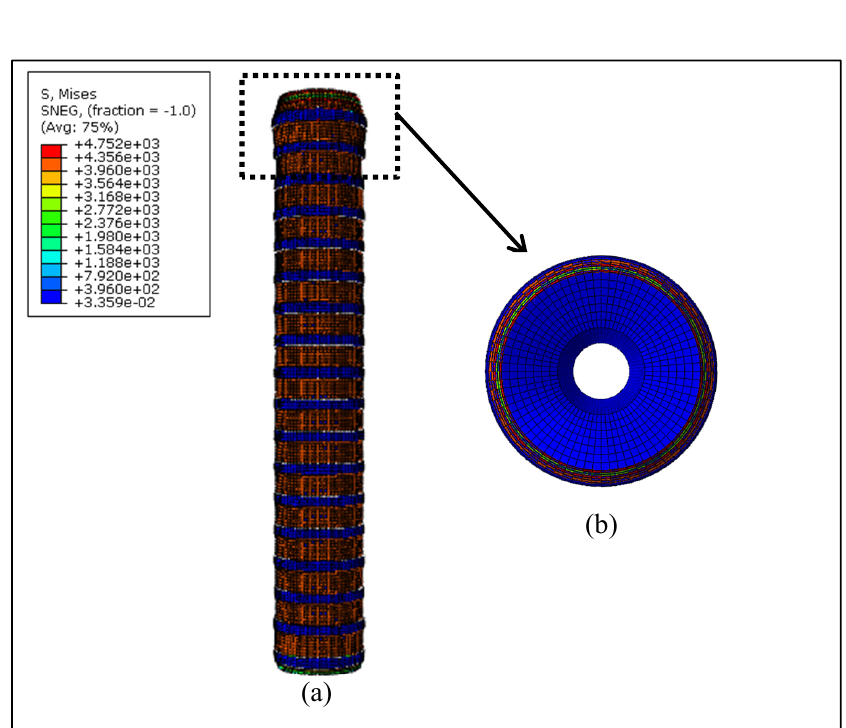
Figure 8. Predicted von Mises stress of circular hollow confined RC column strengthen with partial CFRP sheet (at the end of simulation analysis); (a) Front view (b) Upper plan view showing failure behavior on top of the column.